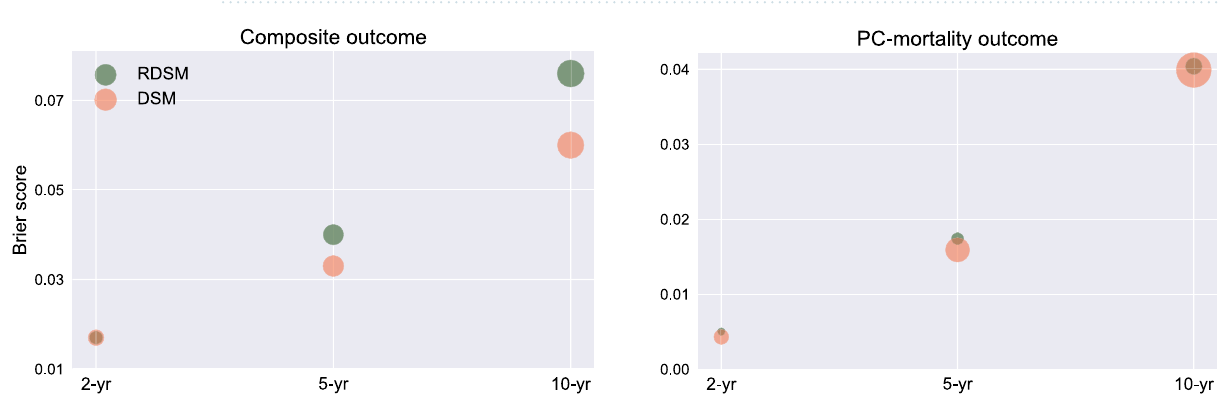
Figure 5. Brier scores for RDSM and DSM at different event horizons for composite (left) and PC-mortality (right) outcomes. Each dot size is proportional to the corresponding variance v ( t | X )